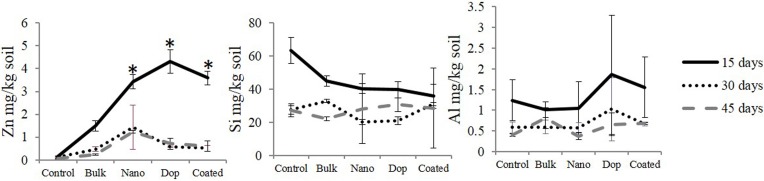
Zinc, silicon, and aluminum dissolution from all the particles after 15, 30, and 45 days at 1000 mg/kg soil concentration. Data points with same/no symbols (*) represent no statistical significance at p ≤ 0.05.